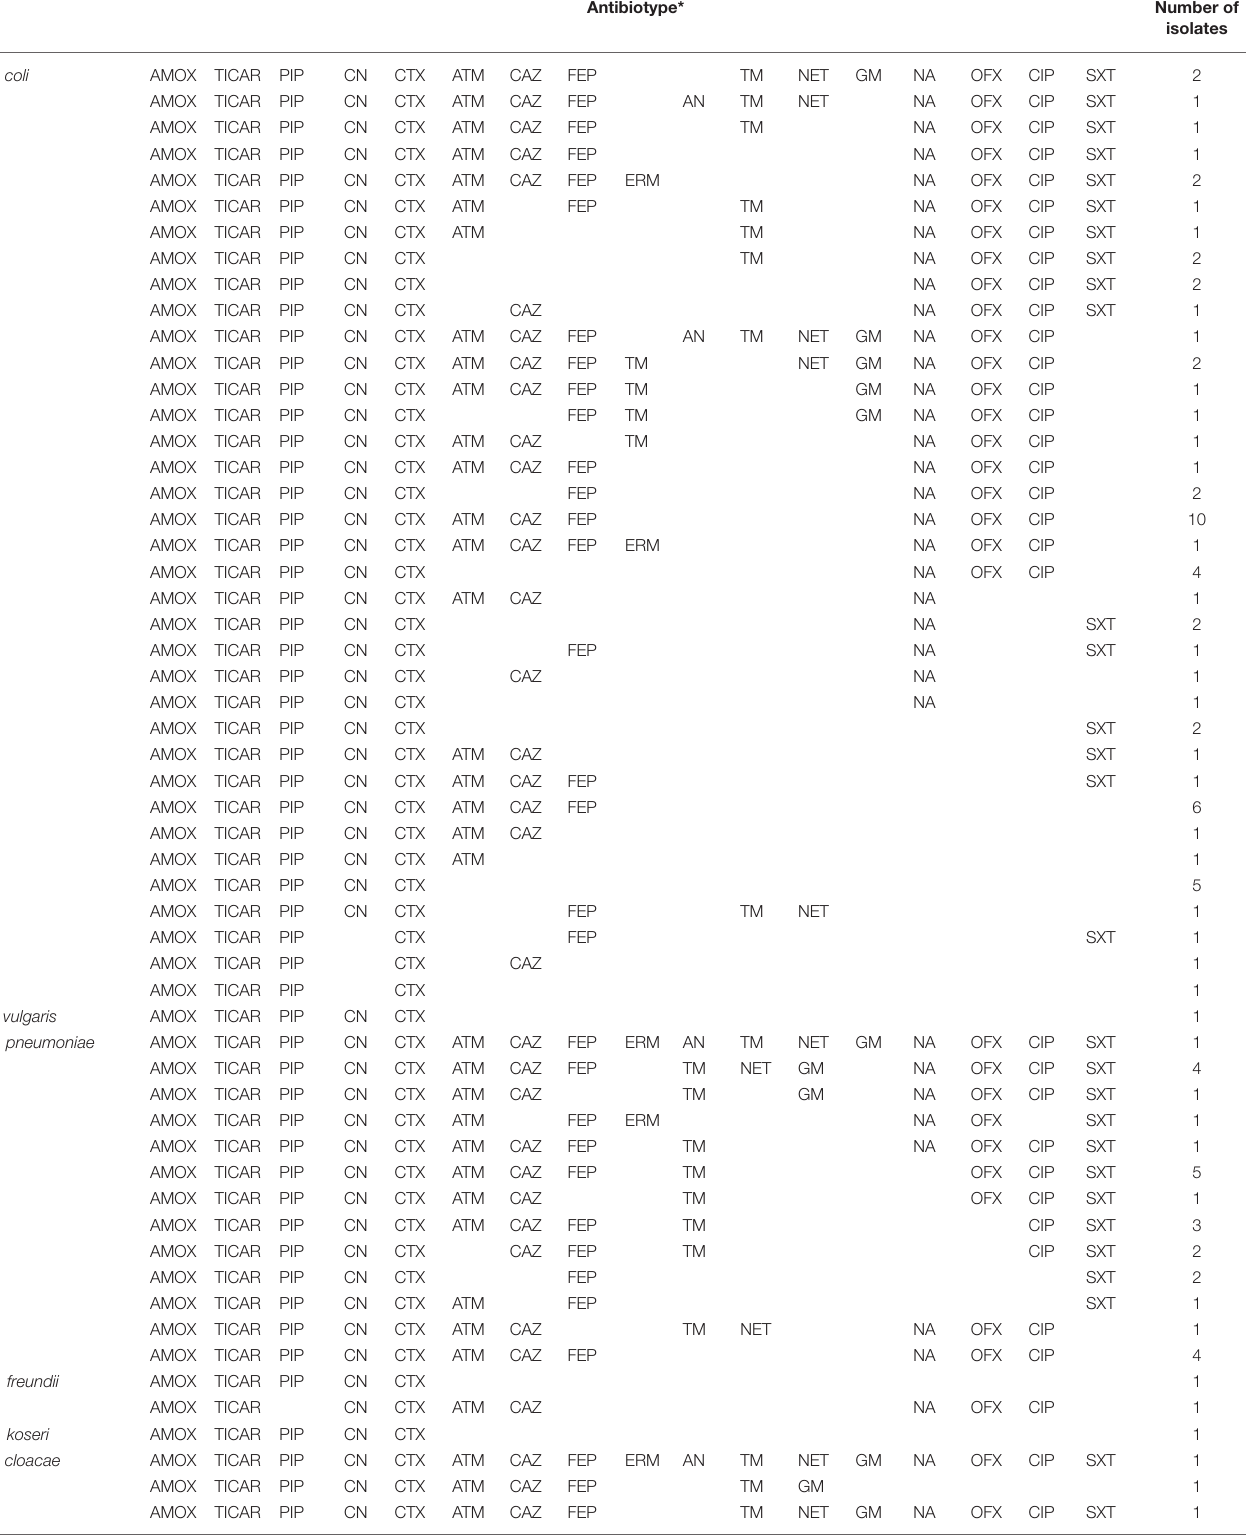
TABLE 2 | Antibiotic susceptibility pattern of the 99 ESBLSE